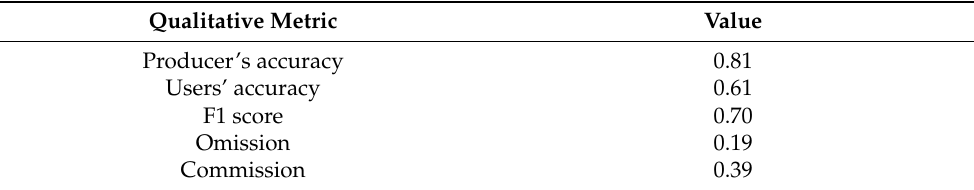
Table 8. Results of the qualitative segmentation assessment. The metrics are computed over 100 manually delimited reference crowns.